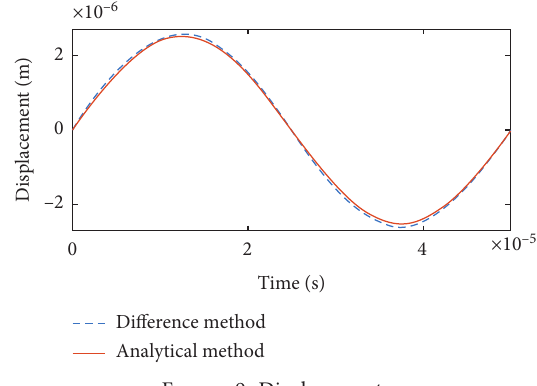
Figure 9: Displacement.